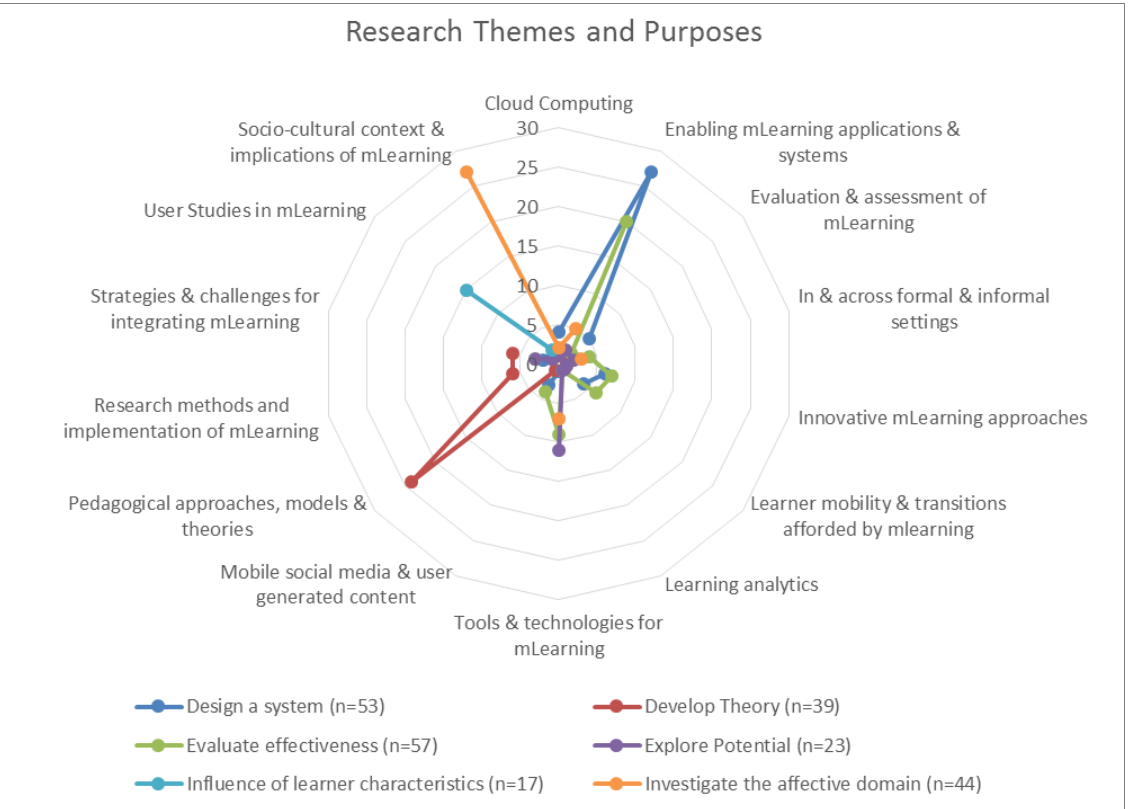
Figure 5. Research themes and purposes radar